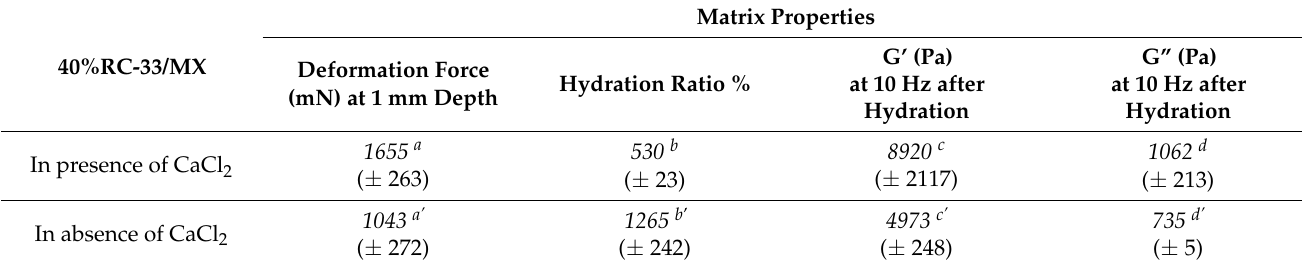
Table 2. Results of the characterization of 40%RC-33/MX, in presence and absence of CaCl 2 (mean values ± s.e.; n = 3).